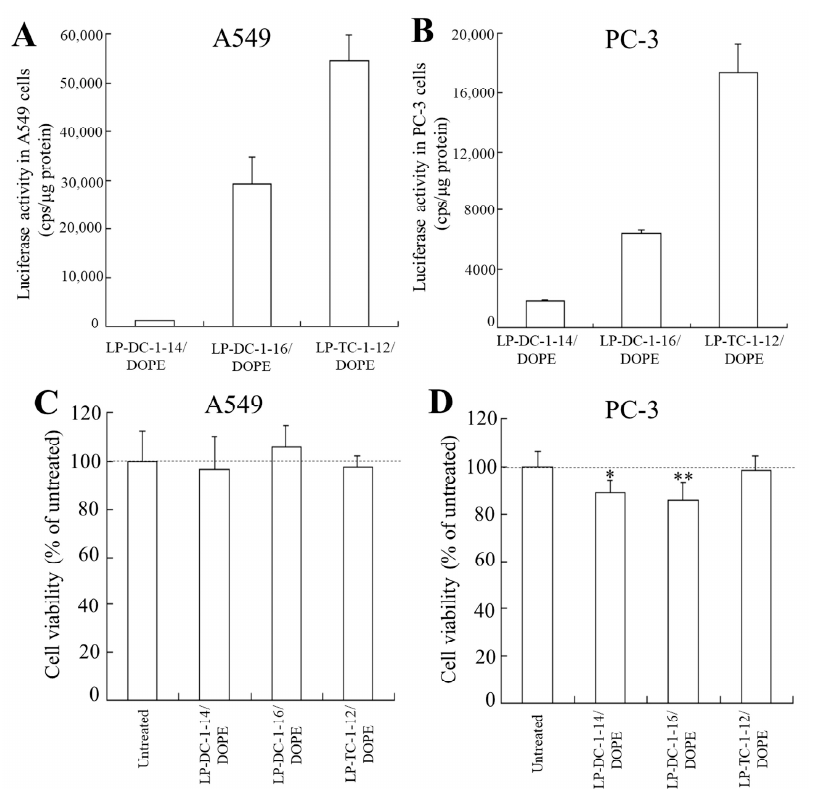
Figure 7. Effect of cell types on luciferase expression and viability in A549 and PC-3 cells after transfection with FLuc mRNA lipoplexes. LP-DC-1-14/DOPE, LP-DC-1-16/DOPE, and LP-TC-1-12/DOPE lipoplexes with FLuc mRNA were added to A549 ( A , C ) and PC-3 cells ( B , D ) at 0.5 µg/mL mRNA, and luciferase activity ( A , B ) and cell viability ( C , D ) were measured 24 h after incubation. Each column represents the mean + S.D. ( n = 3 for A and B, n = 6 for C and D). * p < 0.05, ** p < 0.01, compared to untreated cells.